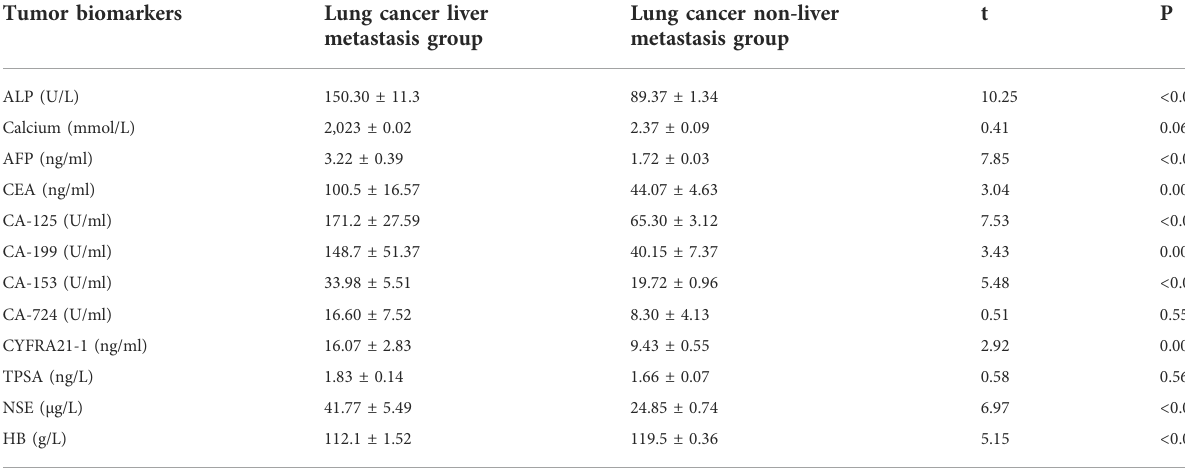
TABLE 2 Differences in tumor biomarkers between liver metastasis of elderly lung cancer and non-liver metastases of elderly lung cancer. Tumor